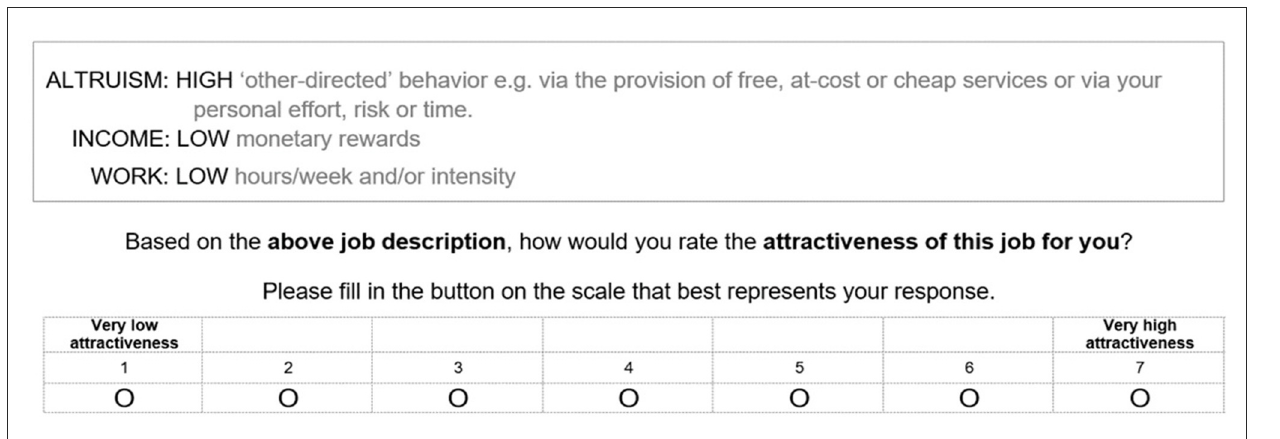
FrontiersinVeterinaryScience